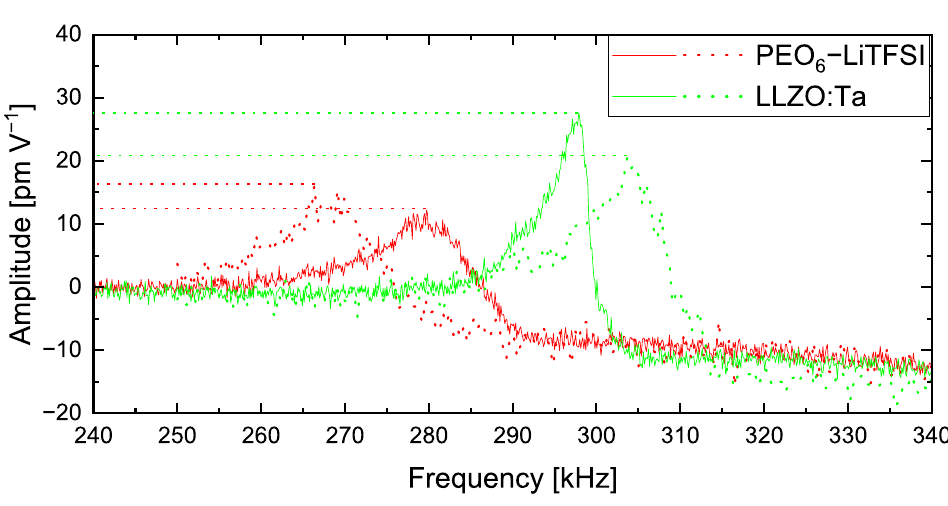
Figure 2. Contact resonance frequency curves on PEO